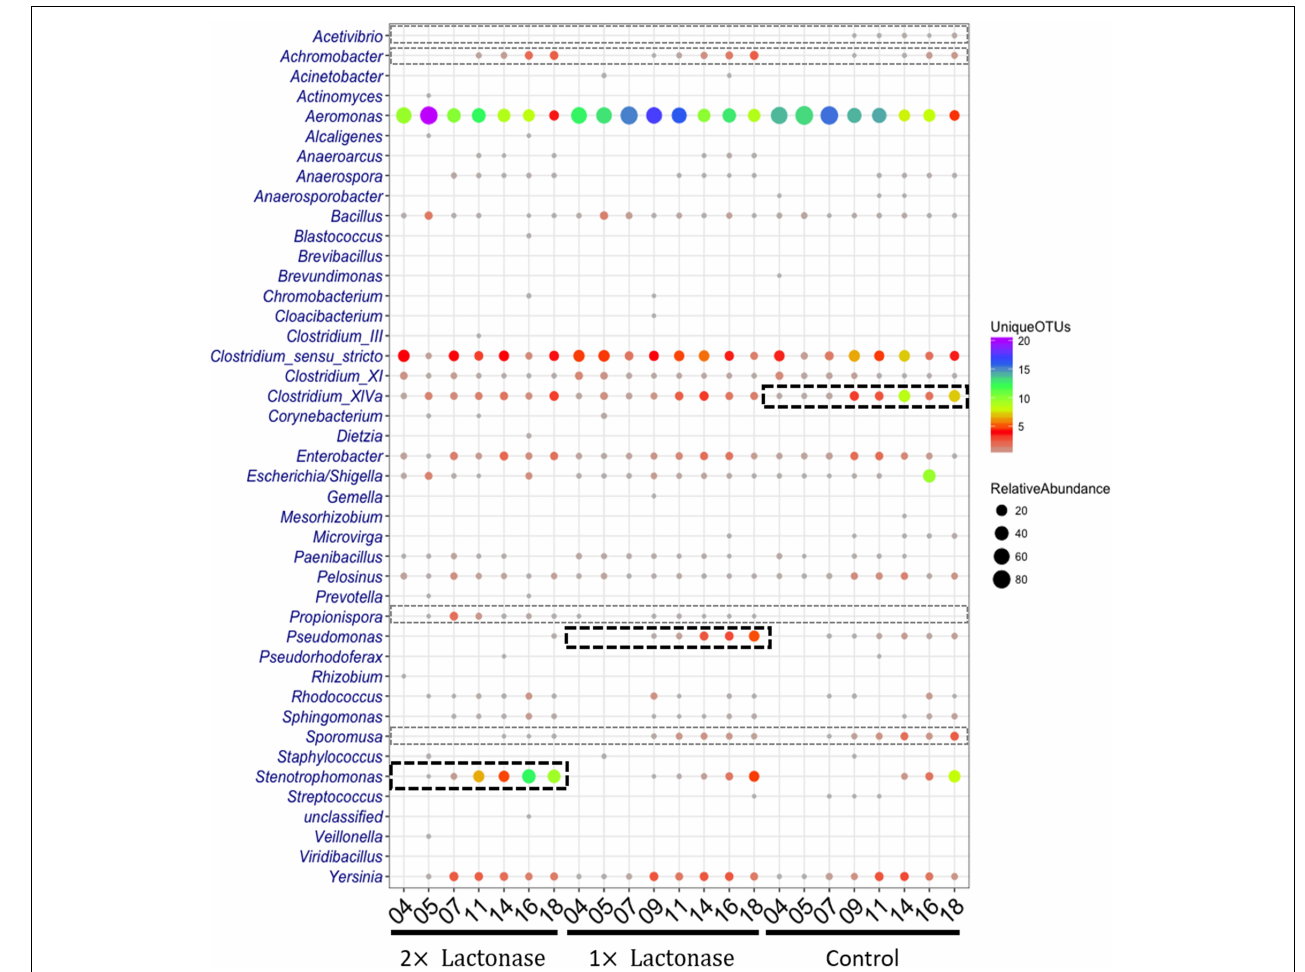
FIGURE 6 | The shift of relative abundance and diversity of bacterial taxa as a function of lactonase concentration and time at the genus level. The color represents the number of unique OTUs and the size of the circles is propositional to the total number of sequences for each given taxonomic group and sample. Abundant and less abundant genera showing difference in the bioreactors are shown in bold black-hashed boxes and light gray hashed boxes,